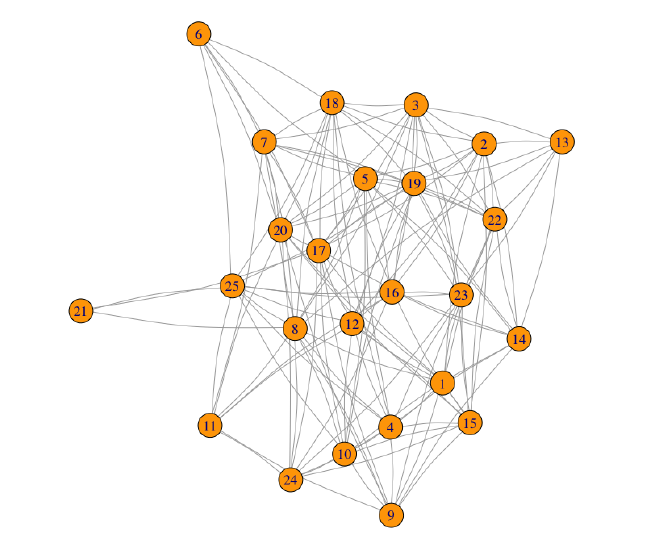
Figure 2. A graph randomly generated with 25